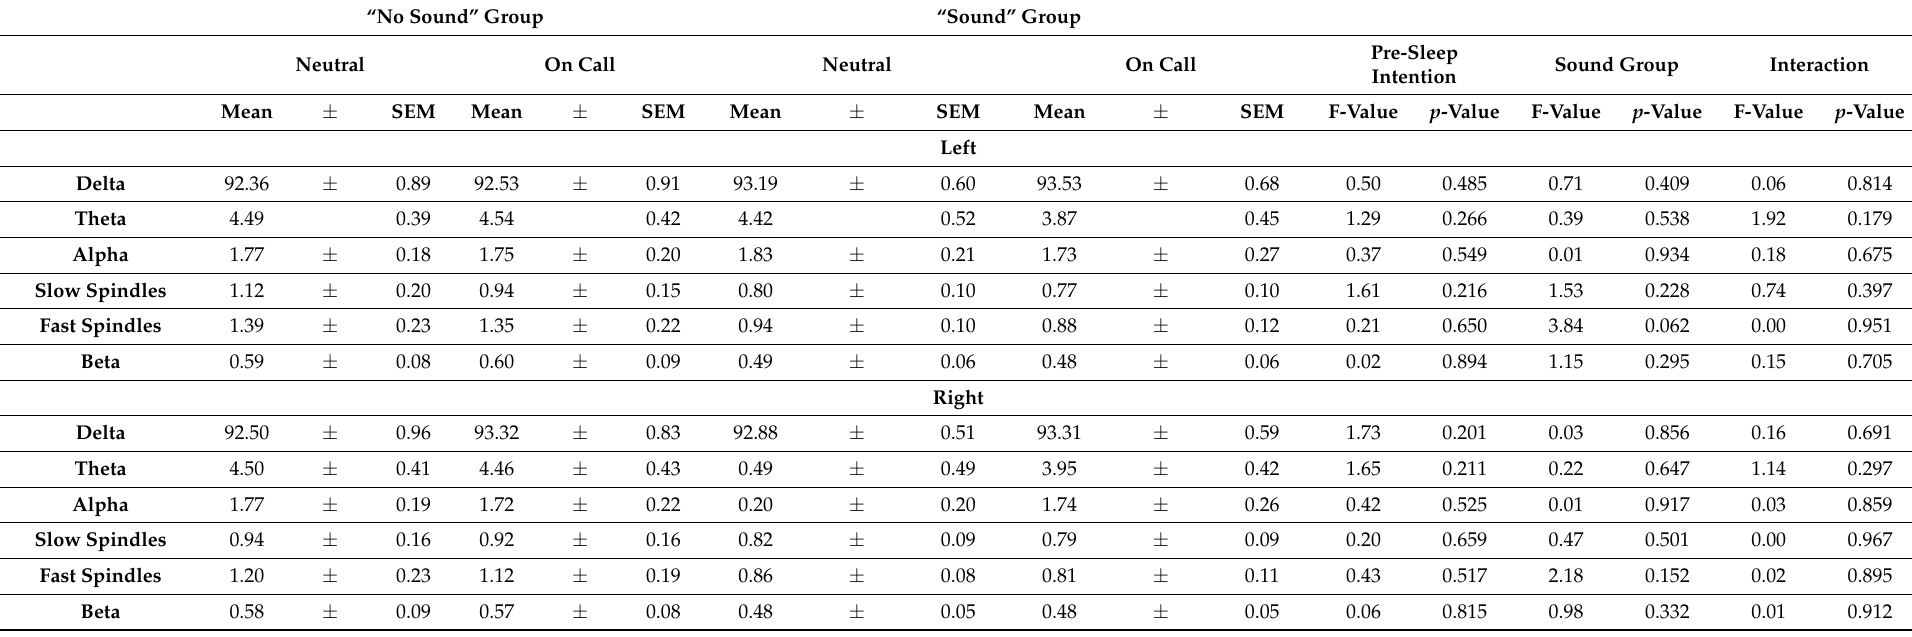
Table 2. Results of the EEG Power Analysis during N2 + N3